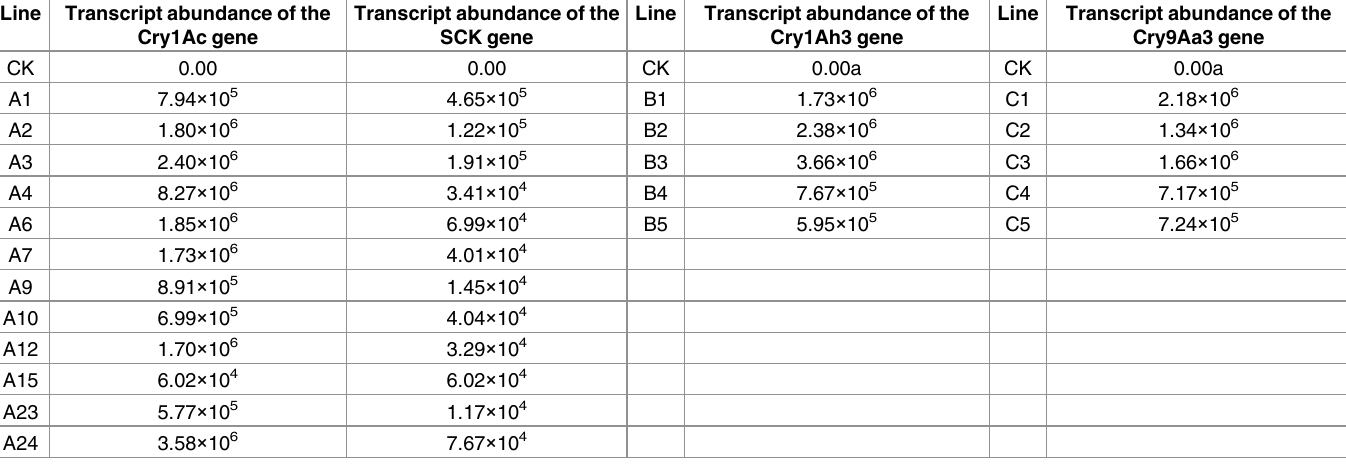
CK means control, which is wild type of poplar.